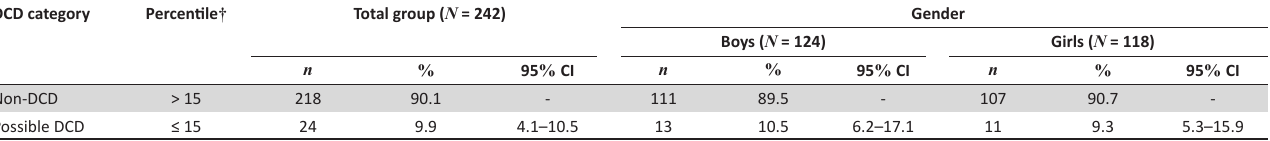
TABLE 3: Percentage of learners without or with possible developmental coordination disorder. DCD category